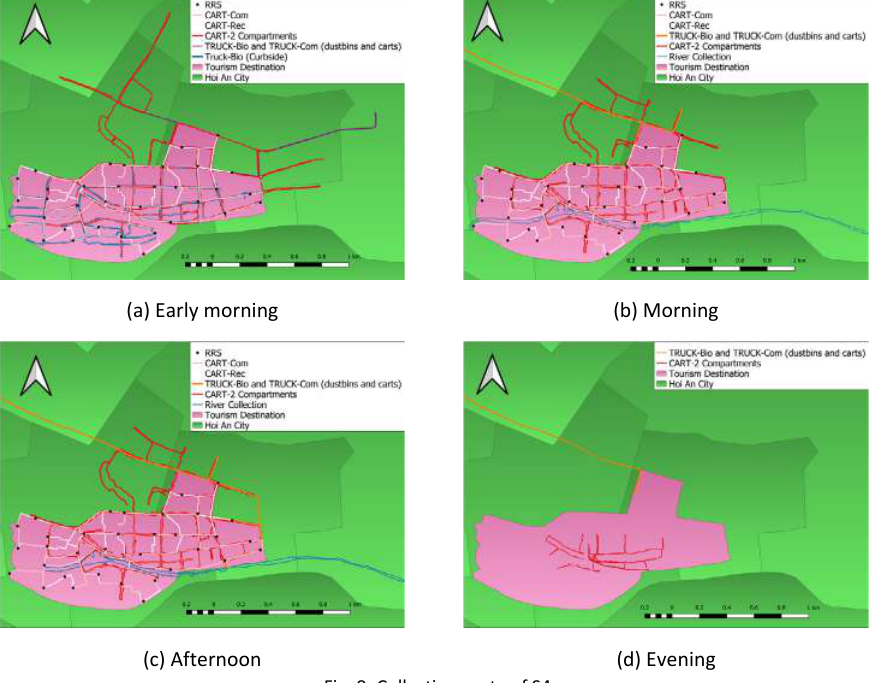
Fig. 9: Collection route of S4